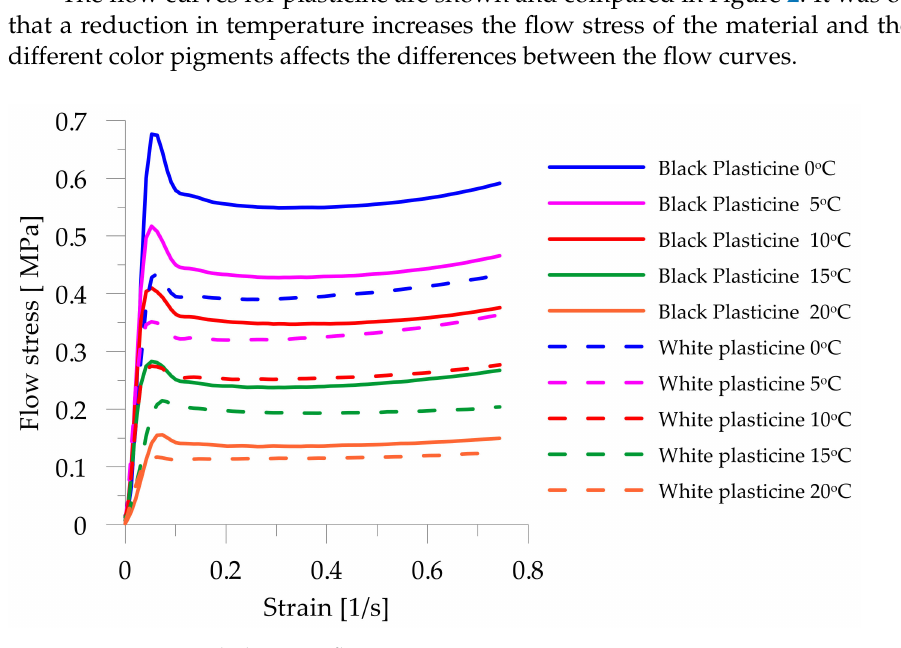
Figure 2. Commercial plasticine flow stress